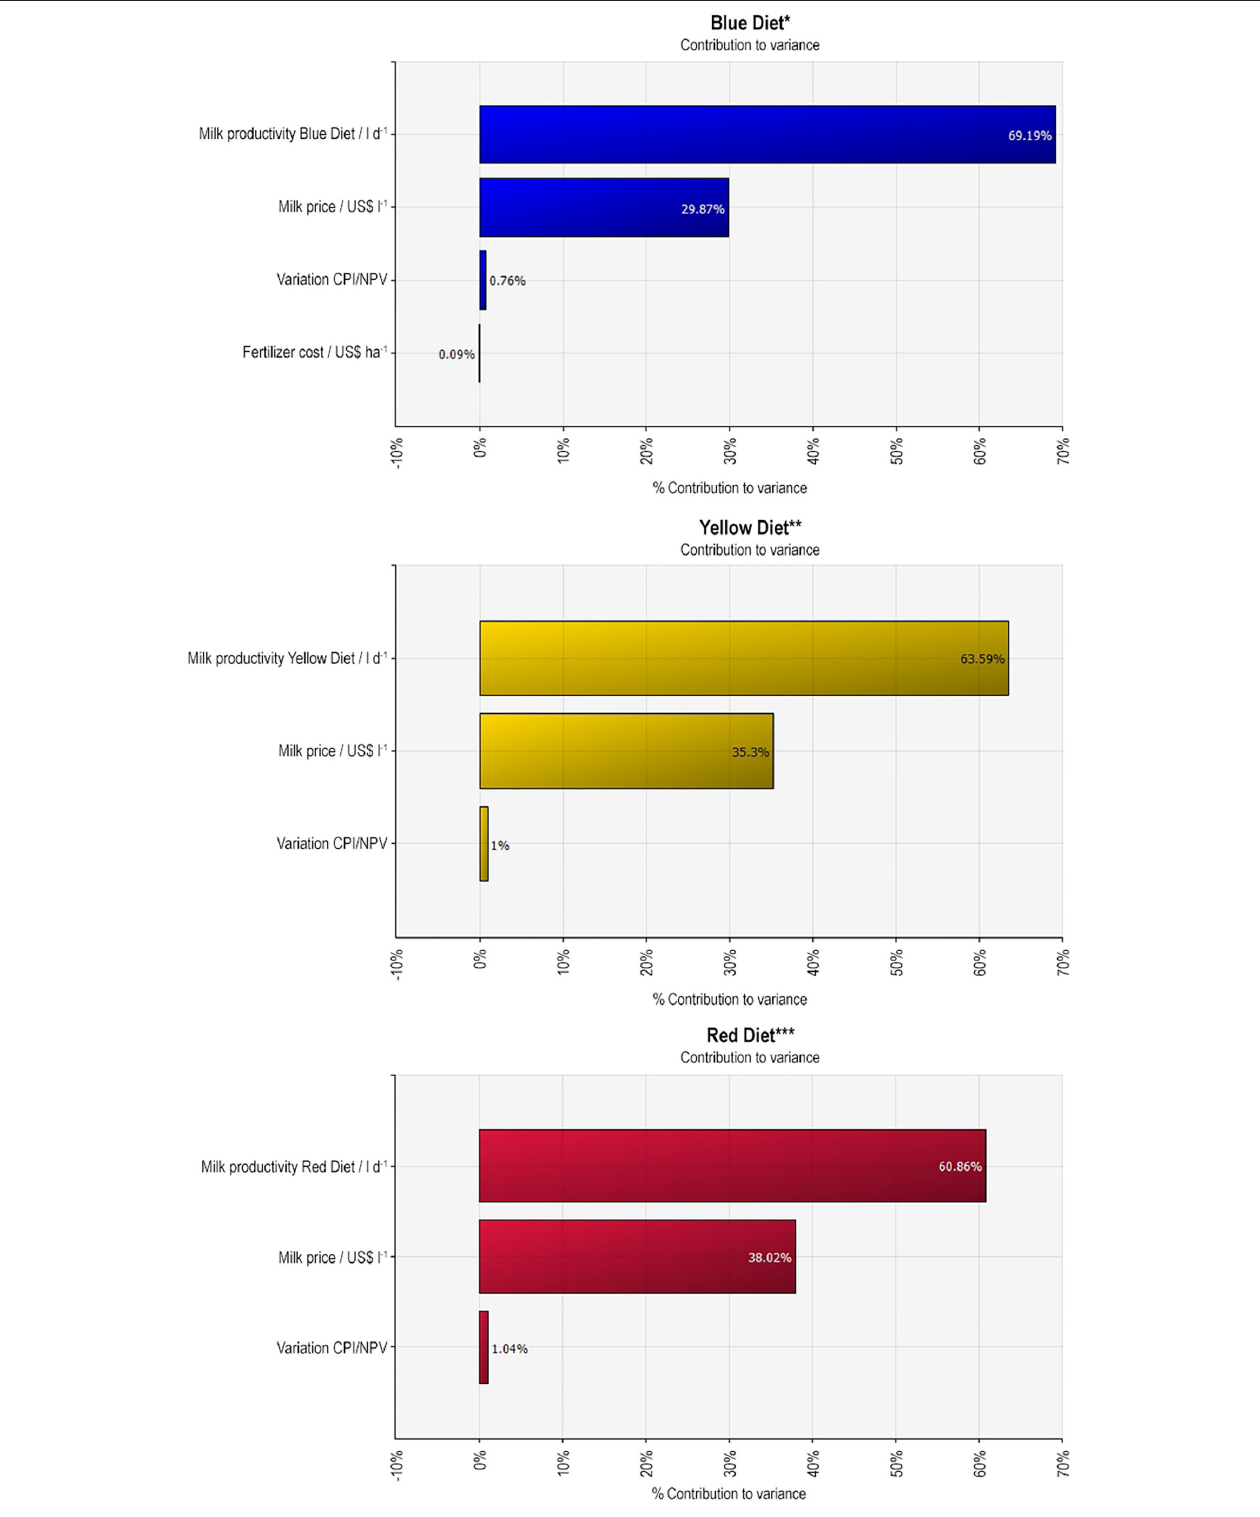
FIGURE 3 | Contribution of variables to the NPV variance for the evaluated diets. *100% Kikuyu grass, **35% Altoandina silage and 65% Kikuyu grass, ***65% Altoandina silage and 35% Kikuyu grass.